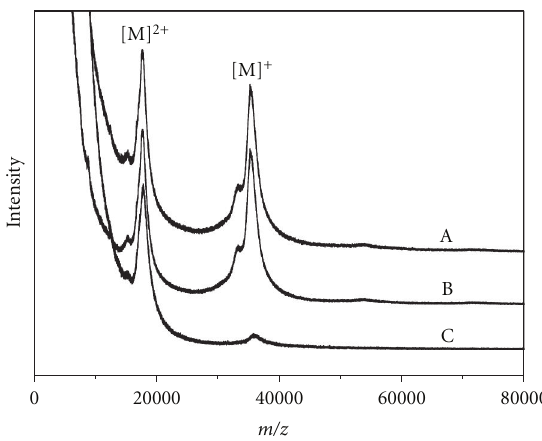
Figure 3: MALDI-TOF MS-positive ion spectra of CALB in GC. A. fresh sample; B. sample after 4 weeks storage; C. sample heated at 96 ◦ C for 10 min.